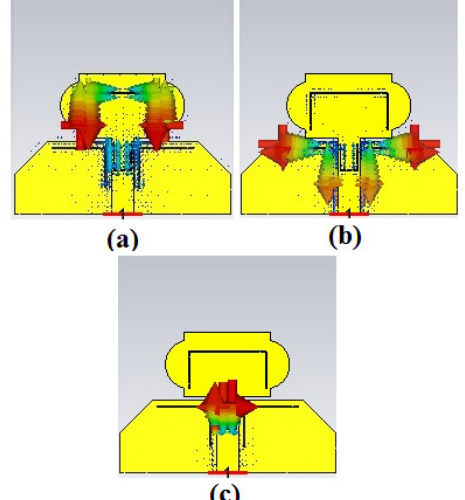
Figure 9: Current Distribution of proposed hammer- shaped Antenna-D at center notch frequency of (a) 3.5 GHz, (b) 5.5GHz, and (c) 7.8 GHz.